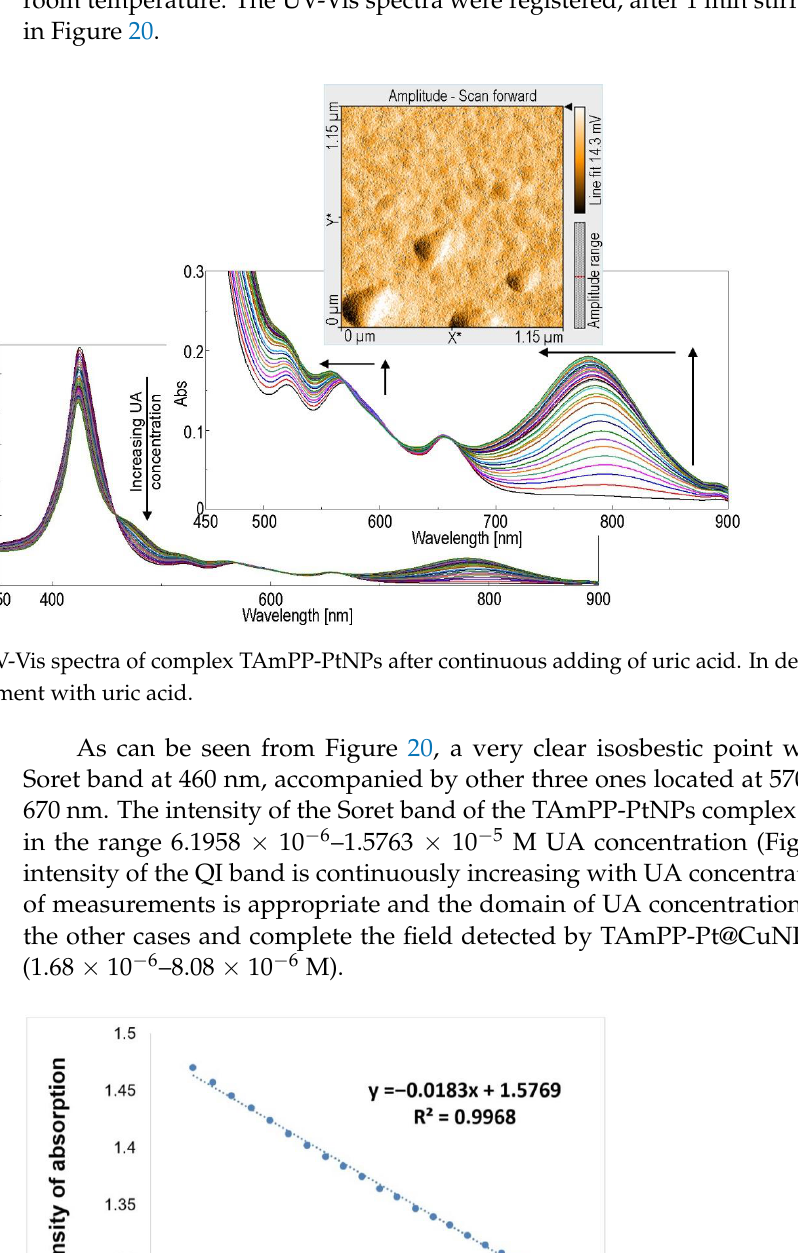
Figure 19. Average percentage errors for UA optical detection using TAmPP-Pt@CuNPs hybrid complex hybrid complex, introduced by different interferences.